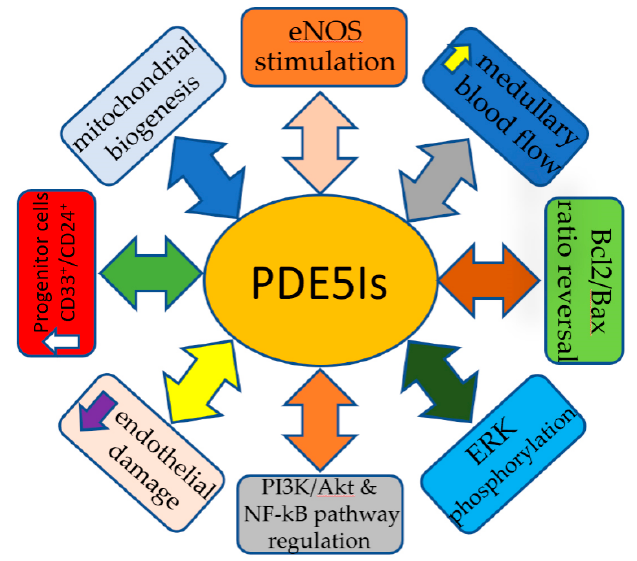
Figure 3. Reno-protective mechanisms of PDE5Is.